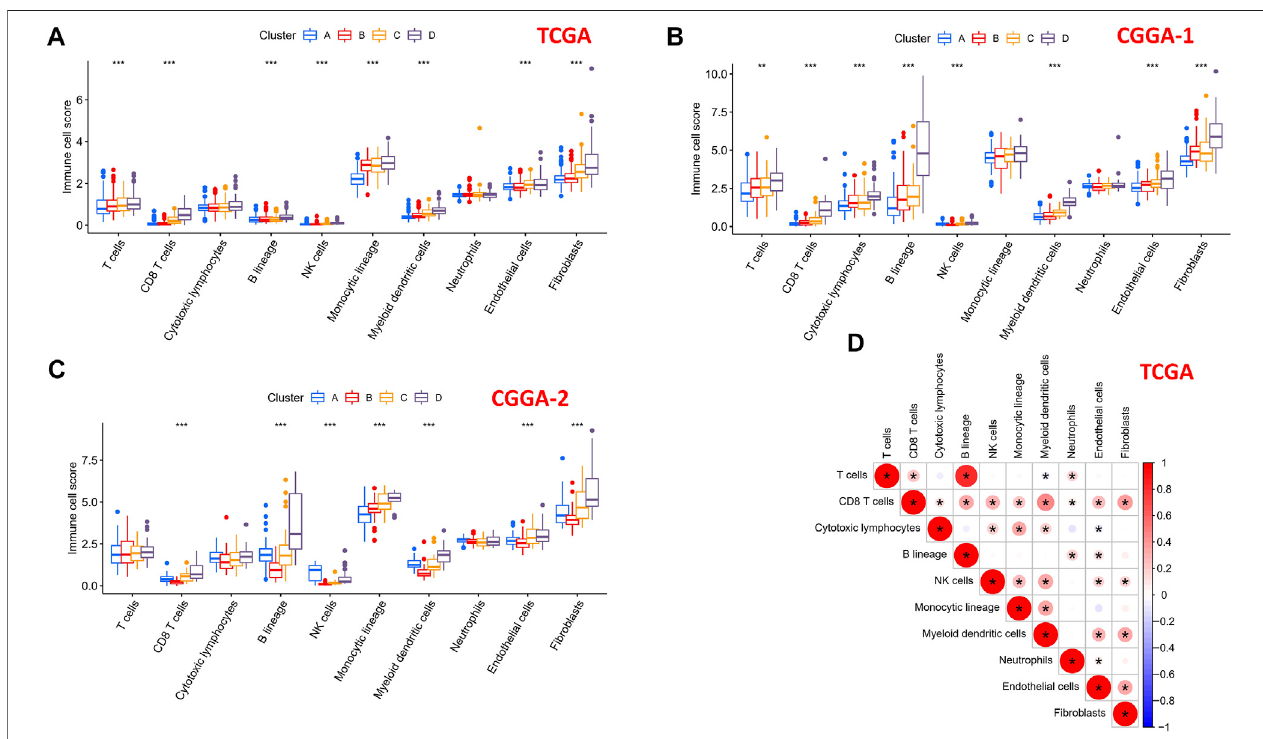
FIGURE 7 | Immune cells scores of the four subtypes in 10 human immunocytes using the MCPcounter algorithm. (A) TCGA, (B) CGGA-1, and (C) CGGA-2 cohorts showed signi fi cantly different immune cell populations among the four subtypes. (D) Intrinsic correlation between in fi ltrating immunocytes and immune scores.